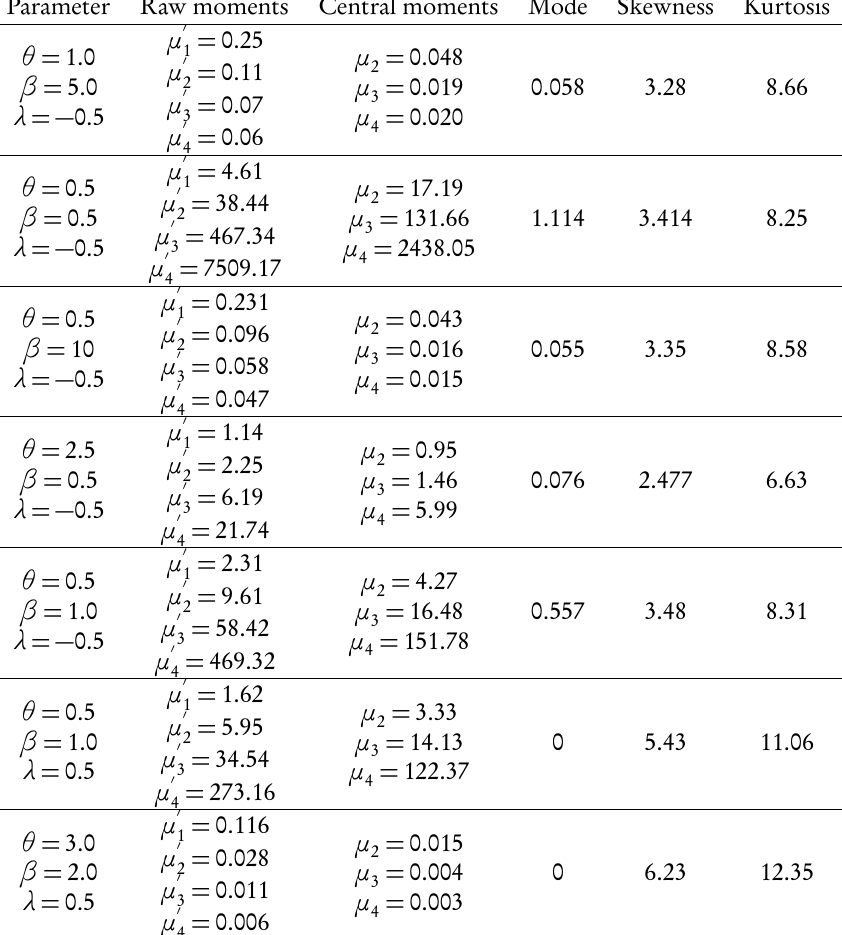
Moments, skewness and kurtosis for various choices of